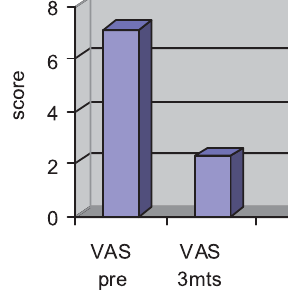
FIGURE 2. The symptom improvement measured by VAS scale. VAS pre: preoperative VAS score; VAS 3mts: VAS score 3 months after surgery.